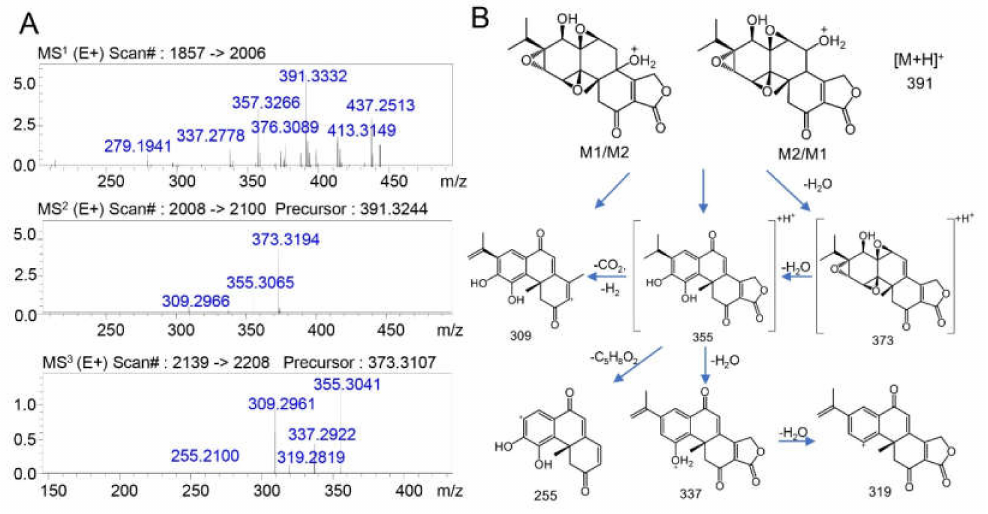
Figure 3. ( A ) The MS n data of the triptolide metabolites M1 and M2. ( B ) Possible structures and mass spectrometric cleavage pathway of metabolites M1 and